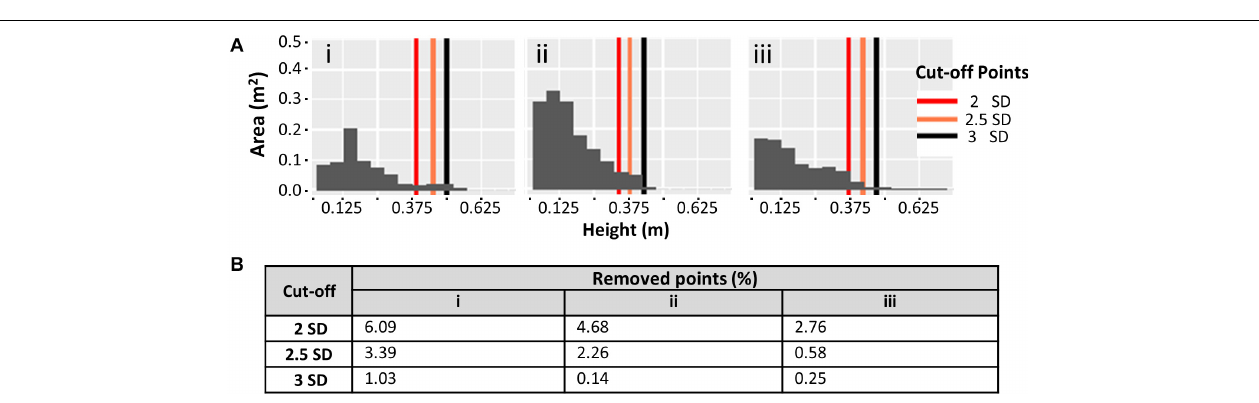
FIGURE 5 | (A) Effect of 3 different standard deviation (SD) cut-offs on plot canopy datasets. Histograms represent the canopy area coverage at different height levels using pre clean up canopy height data. (i–iii) Demonstrate 3 exemplar canopy plots. (B) Percentage of points removed from the point cloud at each SD cut-off for the corresponding histograms in (A)